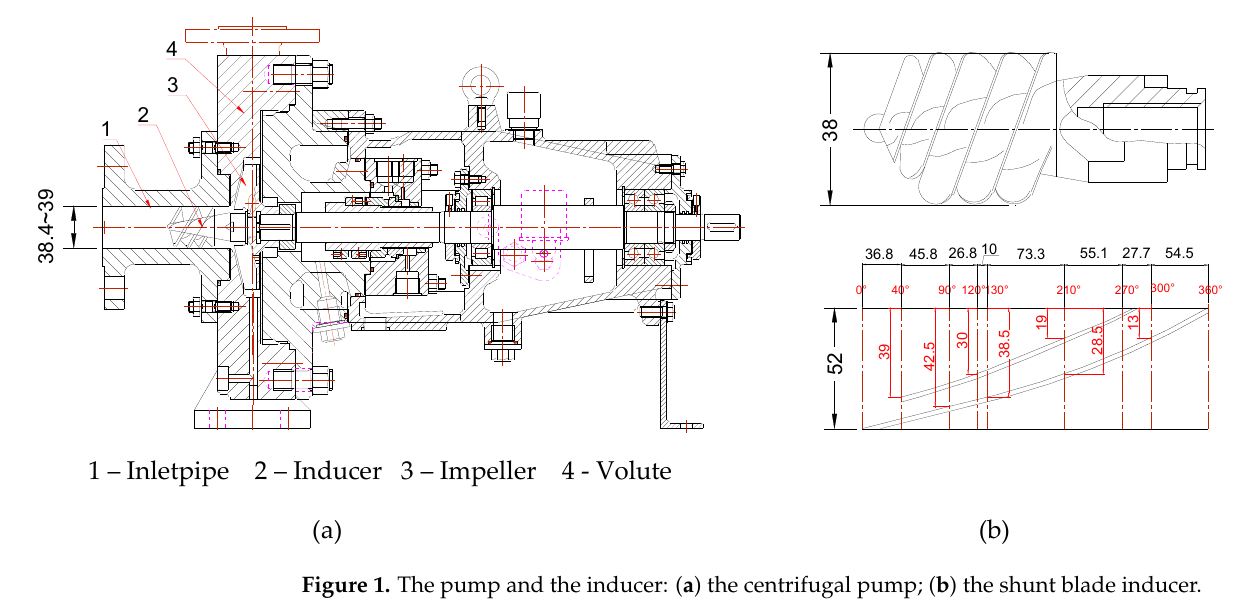
Figure 1. The pump and the inducer: ( a ) the centrifugal pump; ( b ) the shunt blade inducer. Table 1. Parameters of the pump.